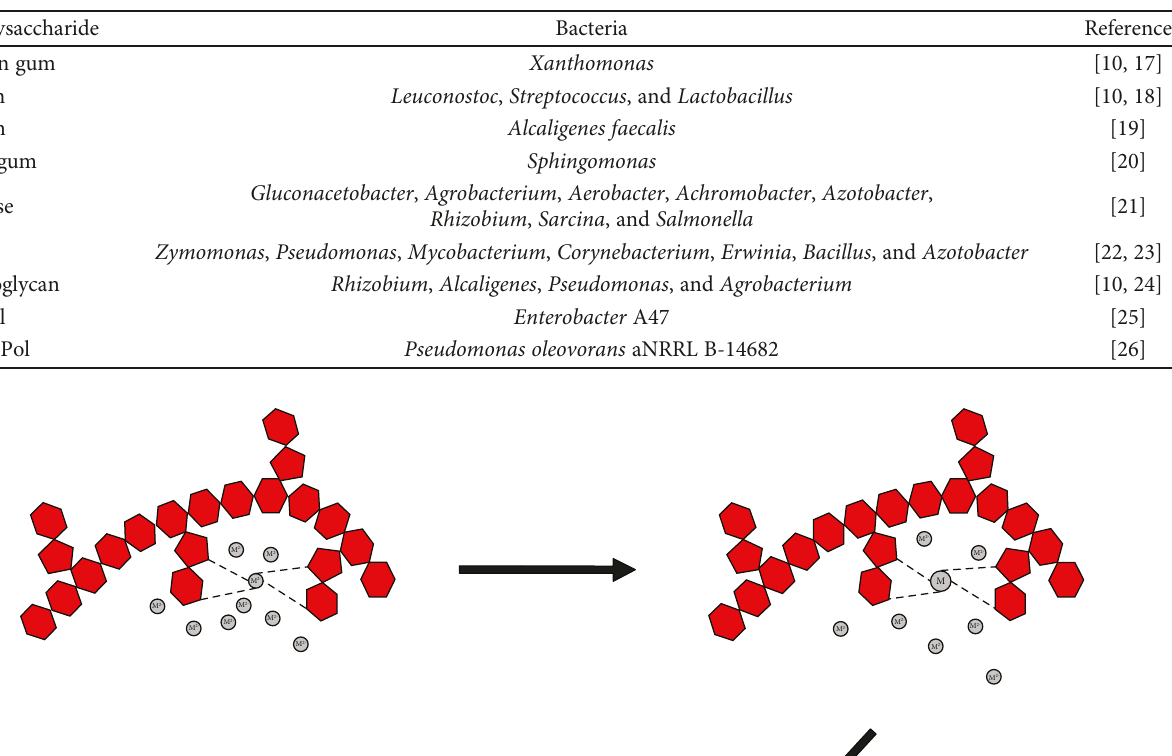
Table 1: Main bacterial EPS and the bacteria that produce them.